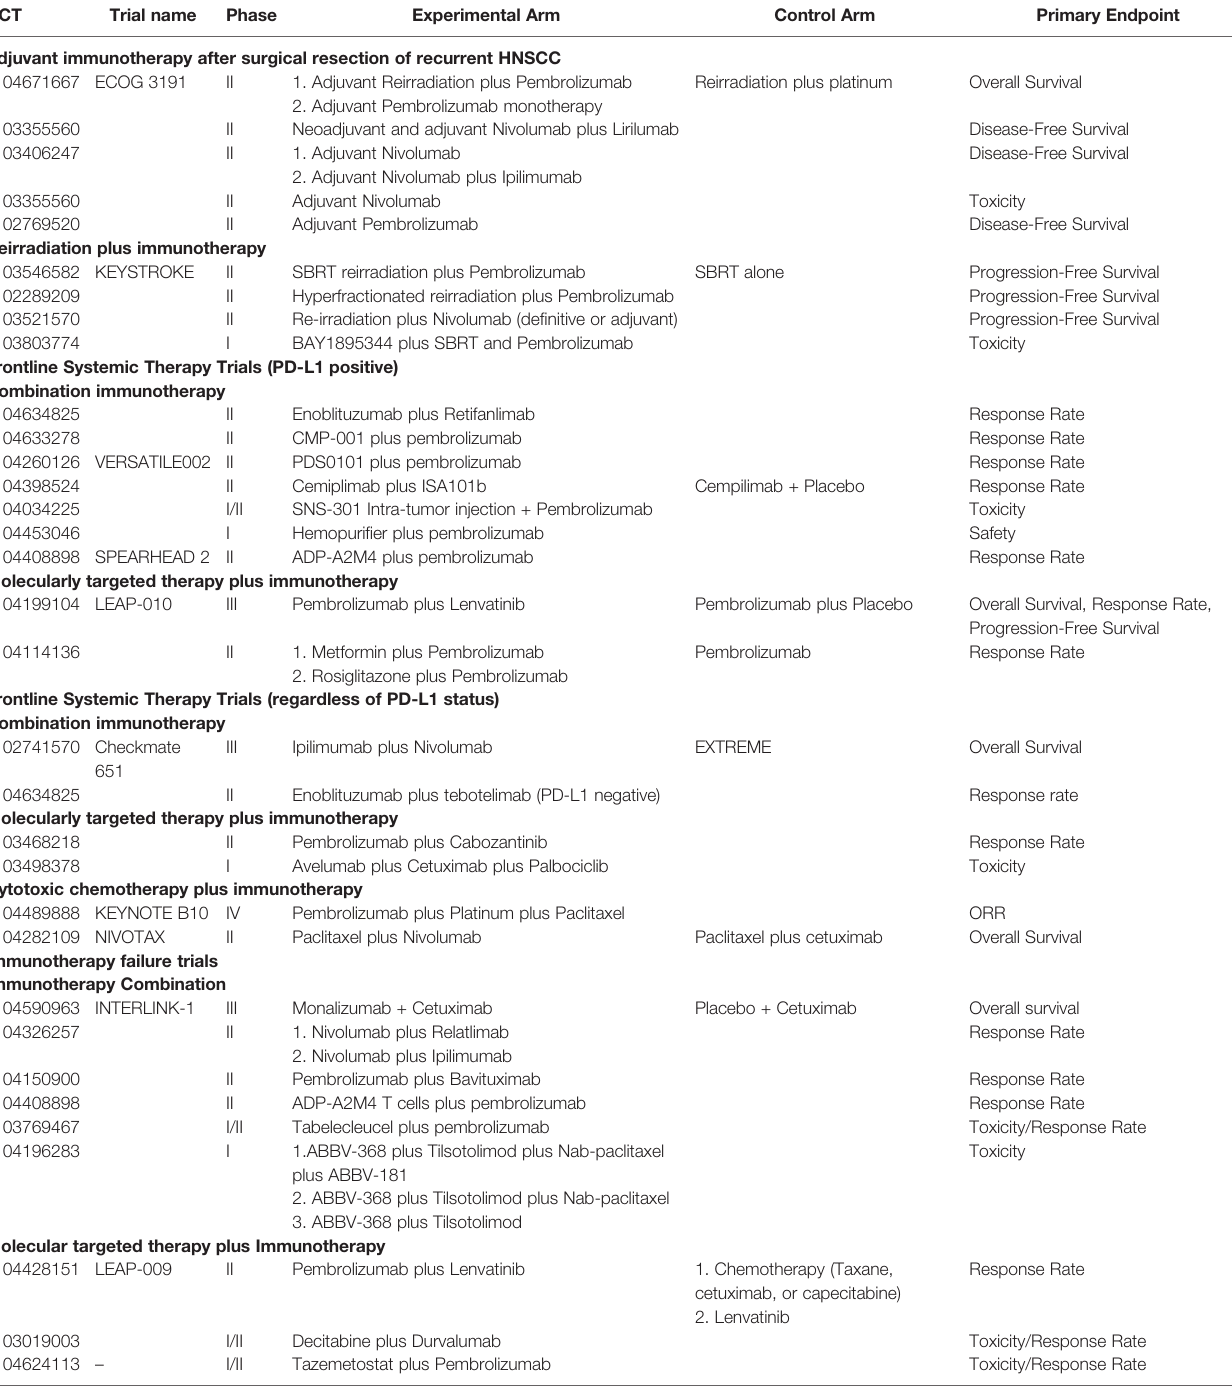
TABLE 2 | Ongoing immunotherapy trials in Recurrent/Metastatic